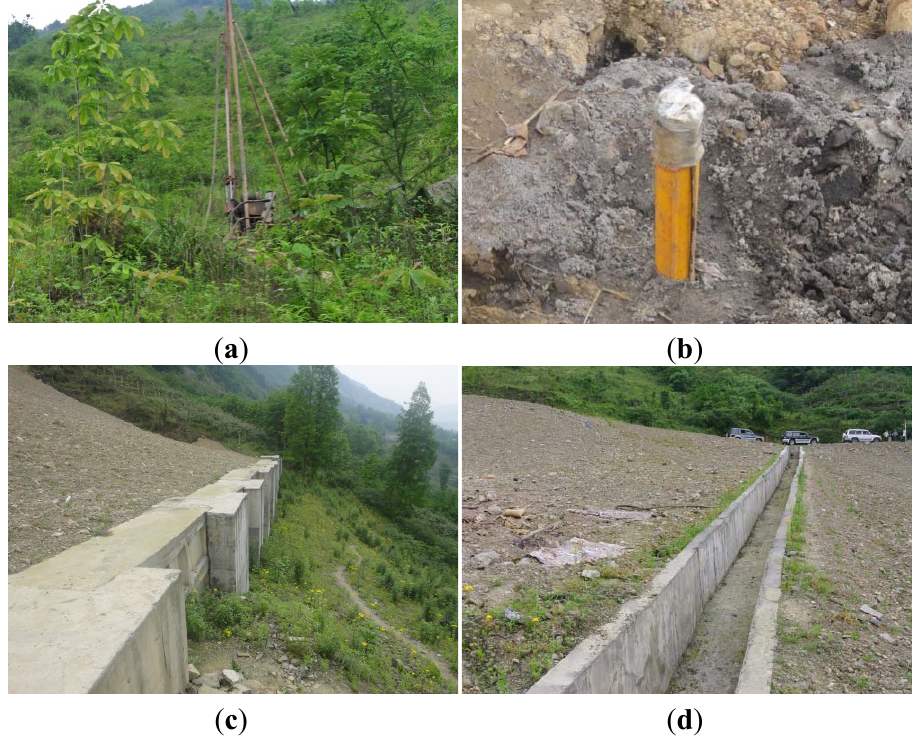
Figure 14. Some existing facilities and sensors at the Taziping landslide: ( a ) Installation